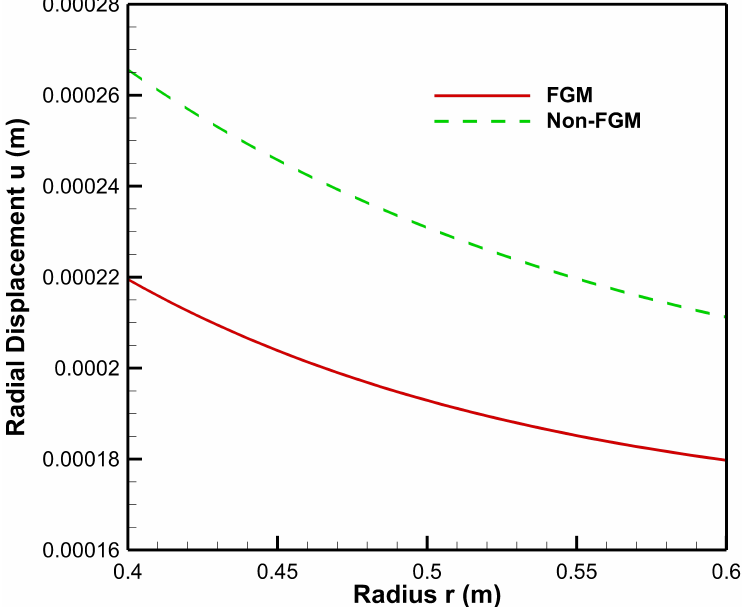
Figure 8. Radial displacement along the radius of the cylinder under internal pressure, P a = 50 MPa.